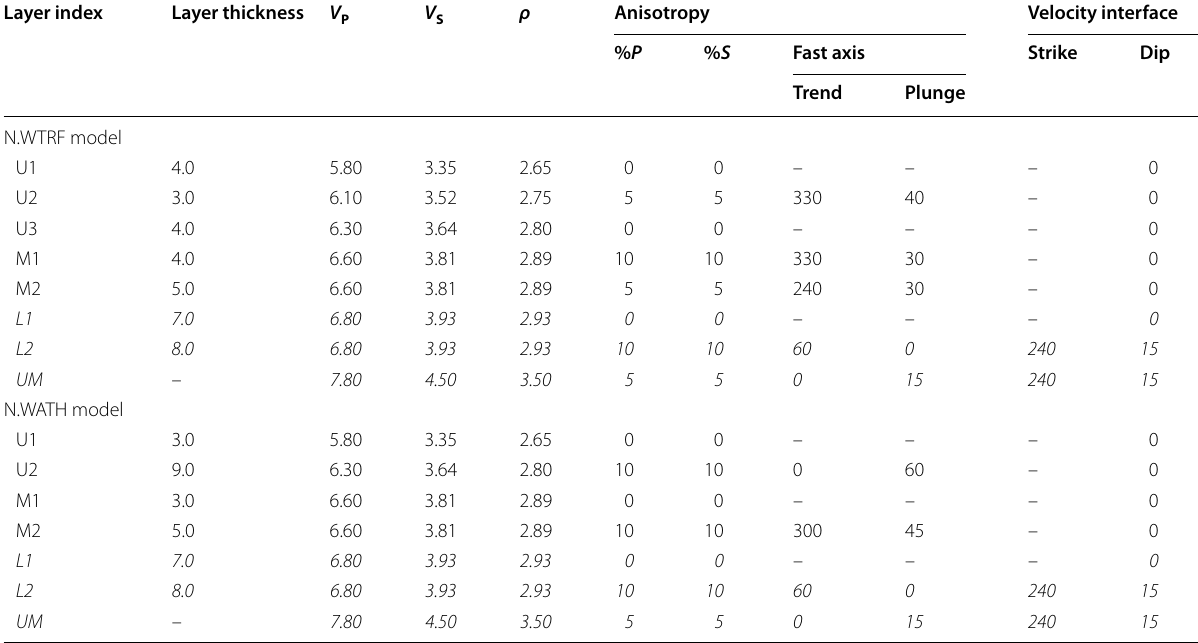
Bottom three layers indicated by italics font are the same for both models. Thickness is in km, V P and V S are in km/s, and ρ (density) is in g/cm